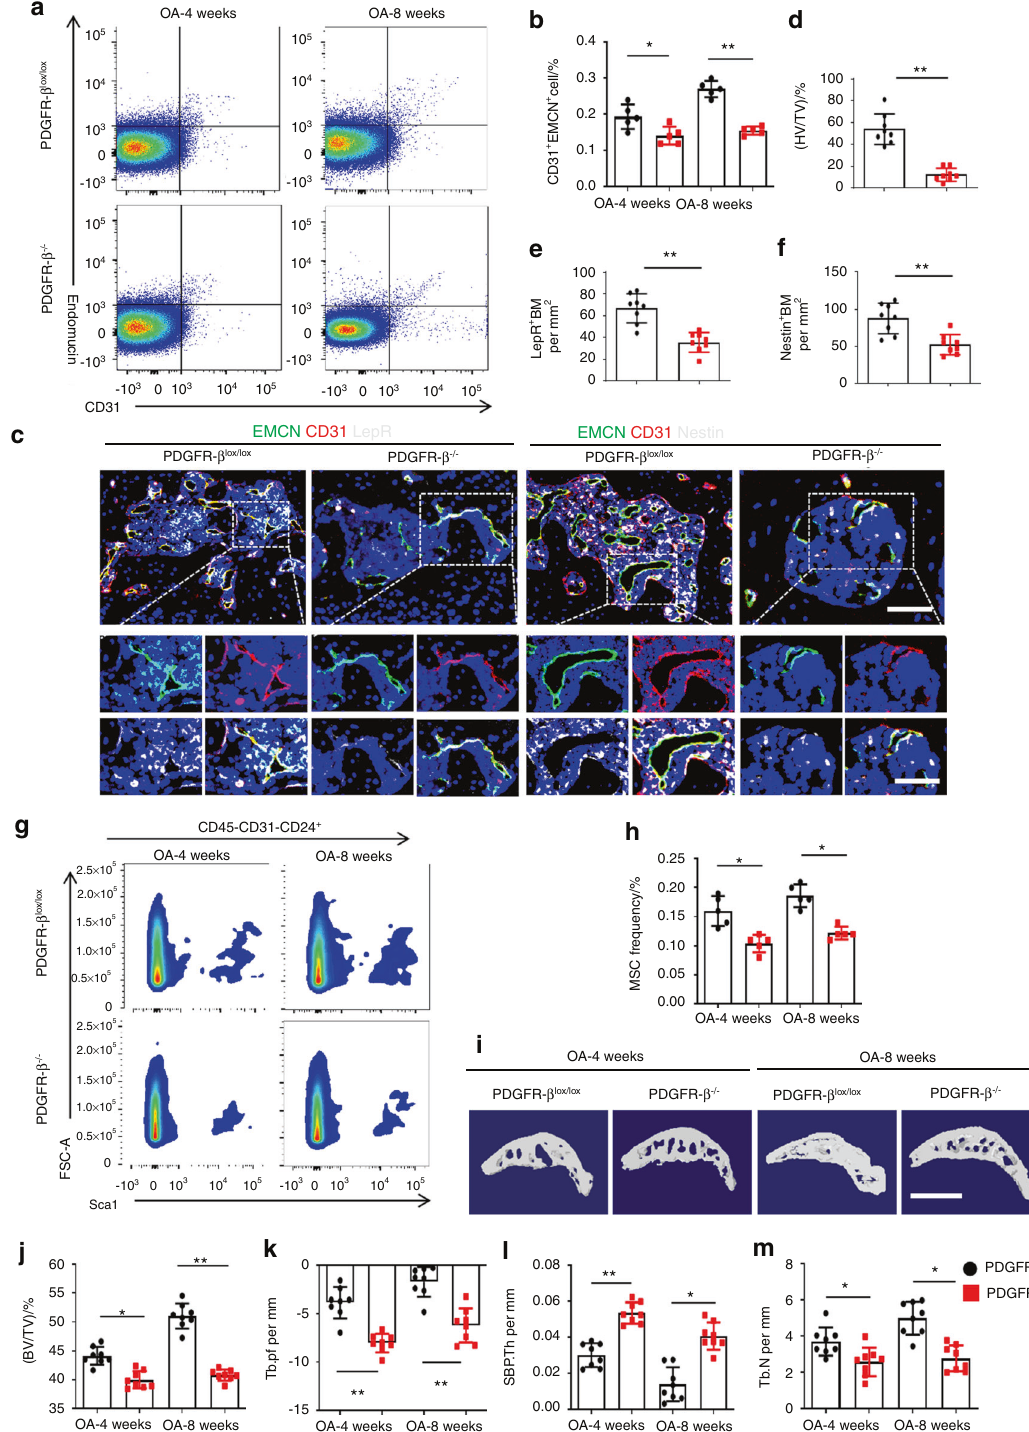
Fig. 4 Endothelial PDGFR- β regulates subchondral H-type vessels and the linked MSCs. FACS analysis ( a ) and quanti fi cation ( b ) of subchondral CD31 hi Emcn hi ECs isolated from the PDGFR- β lox/lox and PDGFR- β − / − mice at 4 weeks and 8 weeks post-ACLT. n = 5 (5 mice with 10 subchondral bone specimens). c Confocal images (upper) with the magni fi ed area (bottom) in the boxed area in the upper image of H-type vessels (merge: yellow; endomucin: green; CD31: red) and LepR + cells (left part, white) and Nestin + cells (right part, white) in the subchondral bone from the PDGFR- β lox/lox and PDGFR- β − / − mice at 4 weeks post-ACLT. Scale bar, bottom 50 µm; top 100 µm. Quanti fi cation of subchondral H-type vessel volume ( d ), LepR + cells ( e ) and Nestin + cells ( f ) from the PDGFR- β lox/lox and PDGFR- β − / − mice at 4 weeks post-ACLT. n = 8. FACS ( g ) and quanti fi cation ( h ) of subchondral MSCs (CD45 − CD31 − Sca1 + CD24 + ) isolated from the PDGFR- β lox/lox and PDGFR- β − / − mice at 4 weeks and 8 weeks post-ACLT. μ CT images of medial subchondral bone ( i ) and quantitative analysis of BV/TV ( j ), Tb.pf ( k ), SBP.Th ( l ), and Tb.N ( m ) in the subchondral bone from the PDGFR- β lox/lox and PDGFR- β − / − mice at 4 weeks and 8 weeks post-ACLT. n = 8. Scale bar, 500 µm. * P < 0.05 and ** P < 0.01 compared to the PDGFR- β lox/lox controls or as denoted by